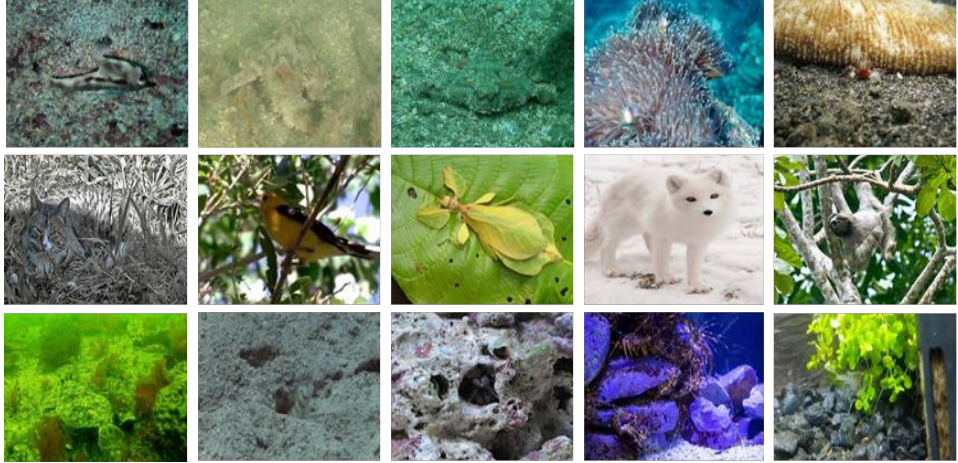
Figure 1. Example of different camouflage objects [4].